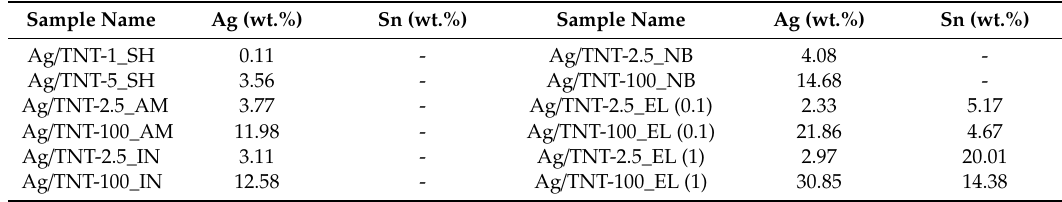
Table 2. Amount of Ag in di ff erent Ag / TNTs nanocomposites measured by